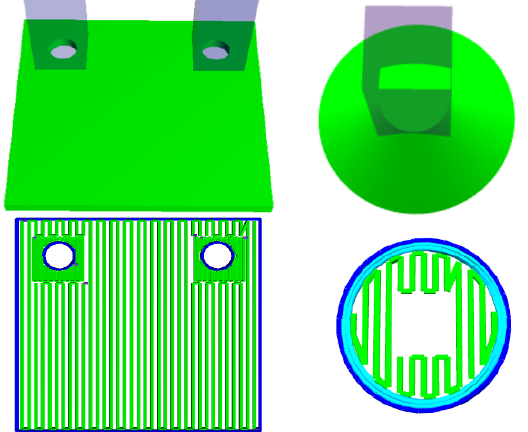
Figure 1. Example of site-specific control application. Left: two rectangles are placed around the holes of the object to densify the infill pattern. Right: Specific areas are overridden to have no infill.